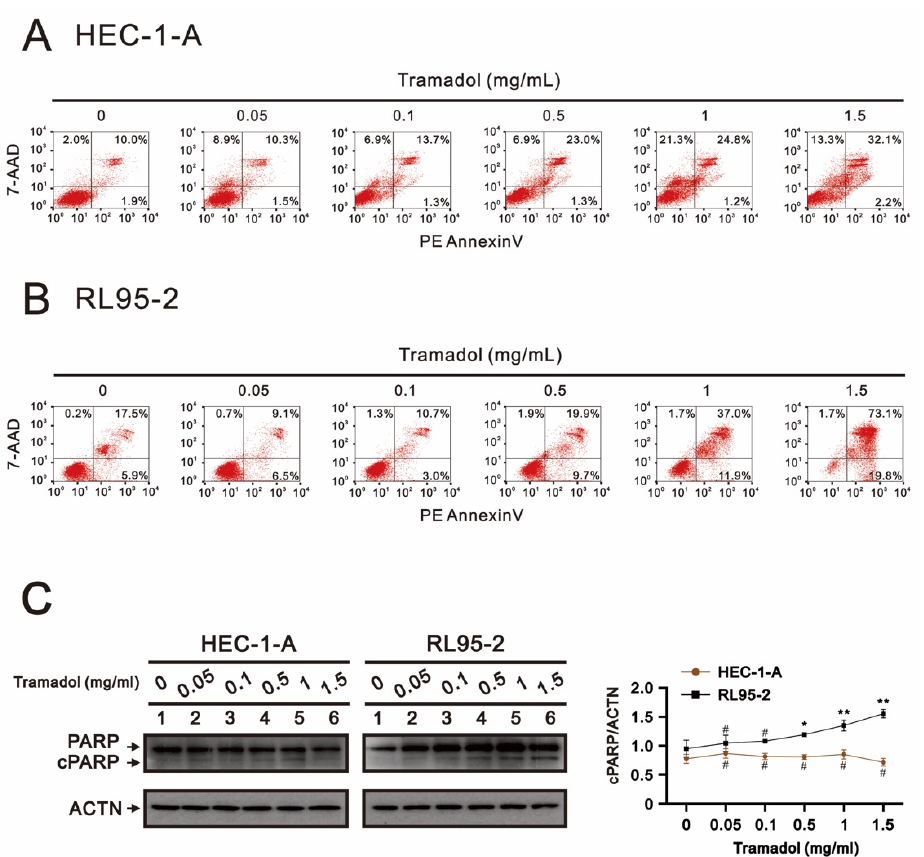
Figure 4. Effects of tramadol on apoptosis of human endometrial cancer cells. ( A , B ) HEC-1-A and RL95-2 cells were treated with tramadol (0, 0.05, 0.1, 0.5, 1, and 1.5 mg/mL) for 24 h. ( C ) HEC-1-A and RL95-2 cells were treated with tramadol (0, 0.05, 0.1, 0.5, 1, and 1.5 mg/mL) for 4 h. Cell lysates were subjected to Western blot analysis using antibodies against cPARP. ACTN was the protein loading control. The protein bands were quantified through pixel density scanning and evaluated using ImageJ, version 1.44a (http://imagej.nih.gov/ij/) (accessed on 12 December 2022). The ratios of cPARP/ACTN were plotted. Bars depict the mean ± SD of three independent experiments. Student’s t -tests were performed, and the results were compared with the vehicle. # p > 0.05, * p < 0.05, and ** p < 0.01 (Student’s t -test).